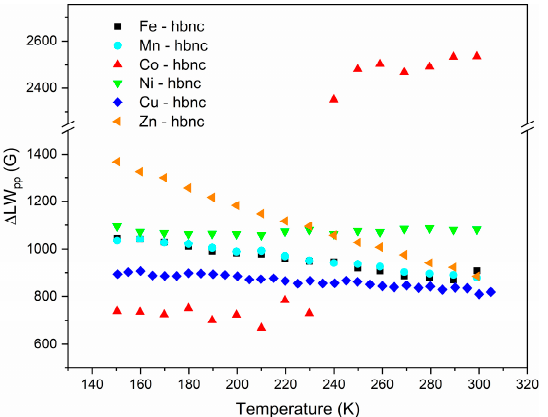
Figure 3. Temperature dependence of the EPR signal peak-to-peak linewidth ( Δ LW PP ) for all species.